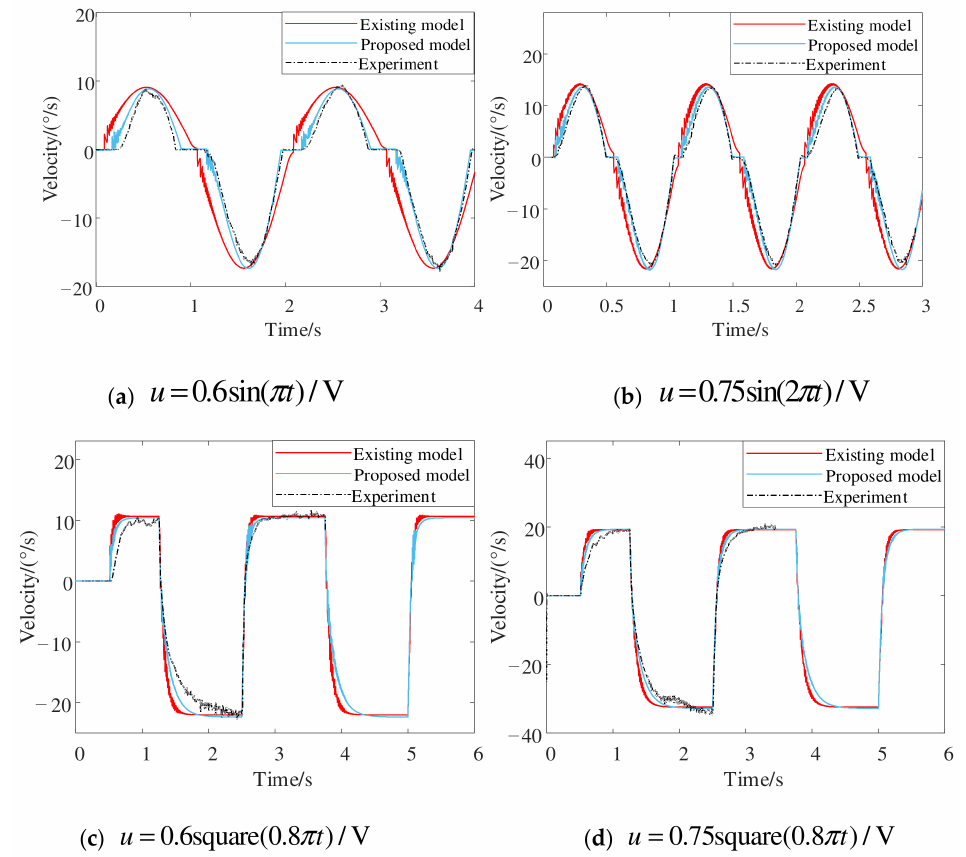
Figure 16. Simulated and experimental time responses under an